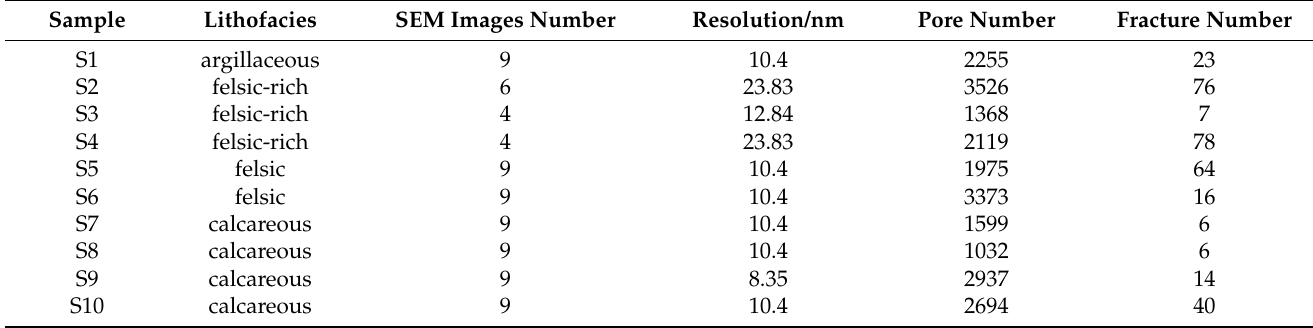
Table 2. Number and resolution of SEM images, pores, and